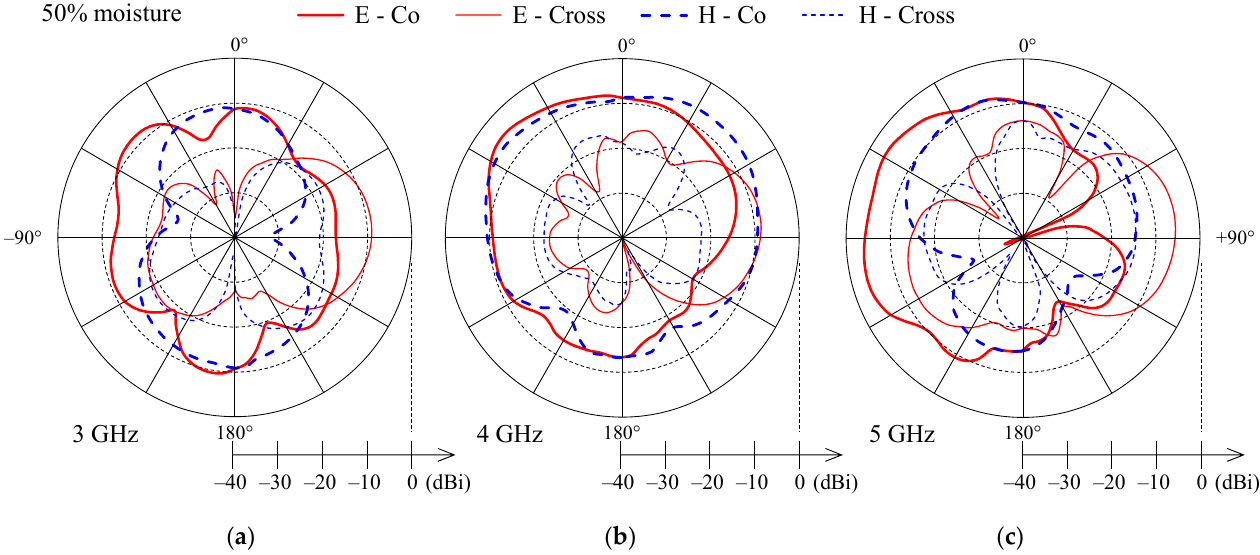
Figure 11. Measured co-polarization (thick line) and cross-polarization (thin line) gain patterns in E-plane (solid) and H- plane (dashed) for the wideband textile monopole with 50% moisture content at ( a ) 3 GHz, ( b ) 4 GHz, and ( c ) 5 GHz. H-plane co-polarization gain patterns for 0%, 50% and 100% moisture contents (Fig- ures 10–12) show nearly omnidirectional radiation. Cross-polarization levels (Figures 10– 12) are high and, at some off-broadside angles, exceed the co-polarization ones. However, for antennas which will be integrated in clothes and used on the user’s body, this should not be a drawback, as body movement, antenna bending, and crumpling, as well as com- plex propagation environment, will anyhow affect the polarization of the radiated and received wave.